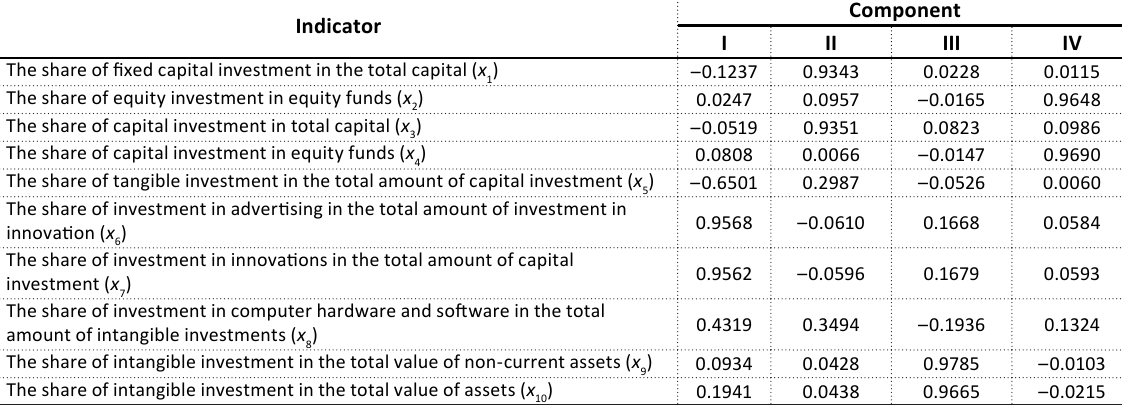
Table 3. Factor loading of investment activity indicators of machine-building enterprises of the Kharkiv